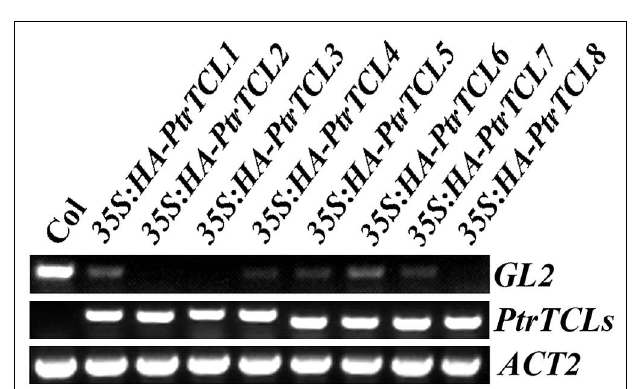
FIGURE 4 | Expression of GL2 and poplar R3 MYB genes in transgenic Arabidopsis plants. RNA was isolated from Col wild-type and transgenic Arabidopsis seedlings, RT-PCR was used to examine the expression of GL2 and polar R3 MYB genes.The expression of ACTIN2 ( ACT2 ) was used as a